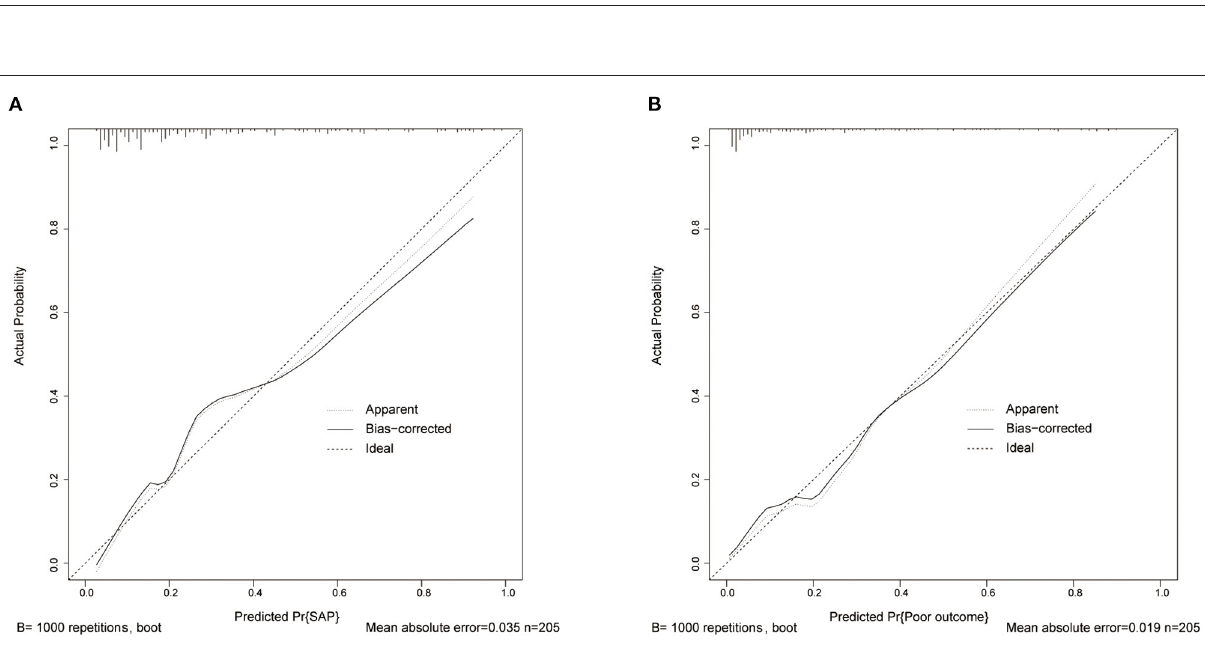
Frontiers in Neurology |